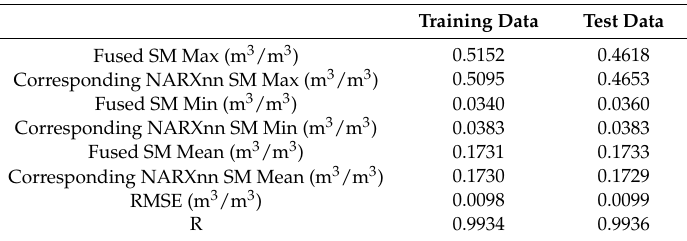
Table 2. Training performance of the NARXnn.